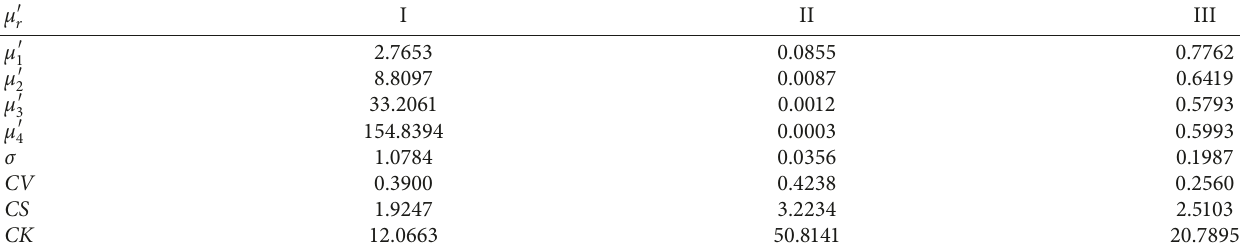
Table 1: First six moments, σ , CV , CS , and CK of the EFL